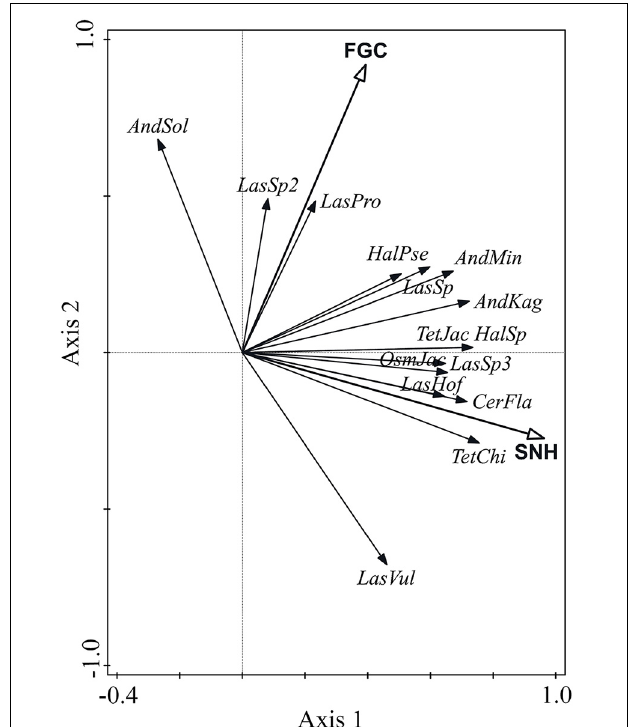
FIGURE 5 | RDA biplot showing the effects of flowering ground cover (FGC) and percent of semi-natural habitats (SNH) on wild bee species composition. The first 15 species with the highest fit in the ordination plot are displayed. AndSol = Andrena solidago , LasSp2 = Lasioglossum sp2, LasPro = Lasioglossum proximatum , HalPse = Halictus pseudovestitus , AndMin = Andrena minutula , LasSp1 = Lasioglossum sp1, AndKag = Andrena kaguya , TetJac = Tetralonia jacoti , HalSp = Halictus sp, OsmJac = Osmia jacoti , LasSp3 = Lasioglossum sp3, LasHof = Lasioglossum hoffmanni , CerFla = Ceratina flavipes , TetChi = Tetralonia chinensis , LasVul = Lasioglossum